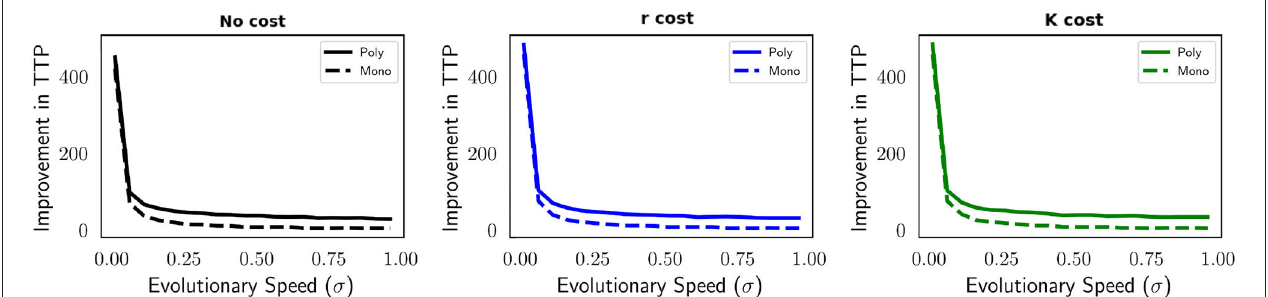
FIGURE 6 | The impact of evolutionary speed on the improvement in TTP for a monomorphic and polymorphic tumor cell population compared between different models of cost of resistance. Compared to Figures 1 – 5 , b is reduced from 10 to 1 and g is reduced from 0.1 to 0.01. Rapid evolution decreases the improvement in TTP provided by AT independent of a resistance cost. Despite the decline, there remains a greater effectiveness of AT when the population is polymorphic. All parameter values used in this figure are: m = 1, K max = 10,000, r max = 0.45, k = 2, b = 1, d = 0.01, g =